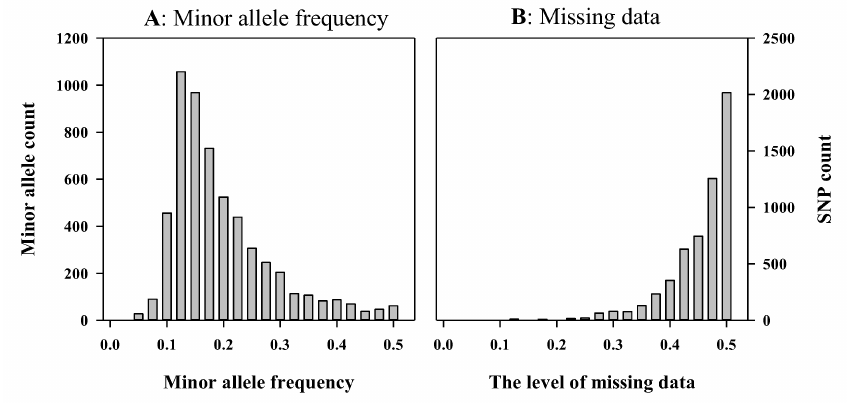
Figure 1. The minor allele frequency distribution ( A ) and the extent of missing data ( B ) for 5659 SNP markers in 119 samples of the 10 northern wheatgrass